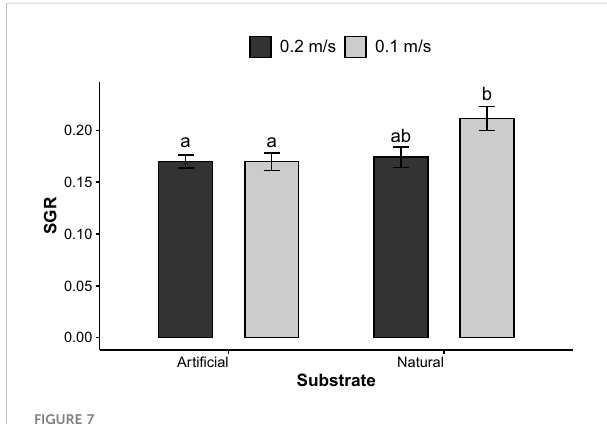
FIGURE 7 Speci fi c growth rate (SGR, % day-1) of S. latissima between days 35 and 42 according to the interaction between substrate (arti fi cial or natural) and water velocities (0.1 or 0.2 m s -1 ); bars with different letters are signi fi cantly different (p< 0.05), n = 6